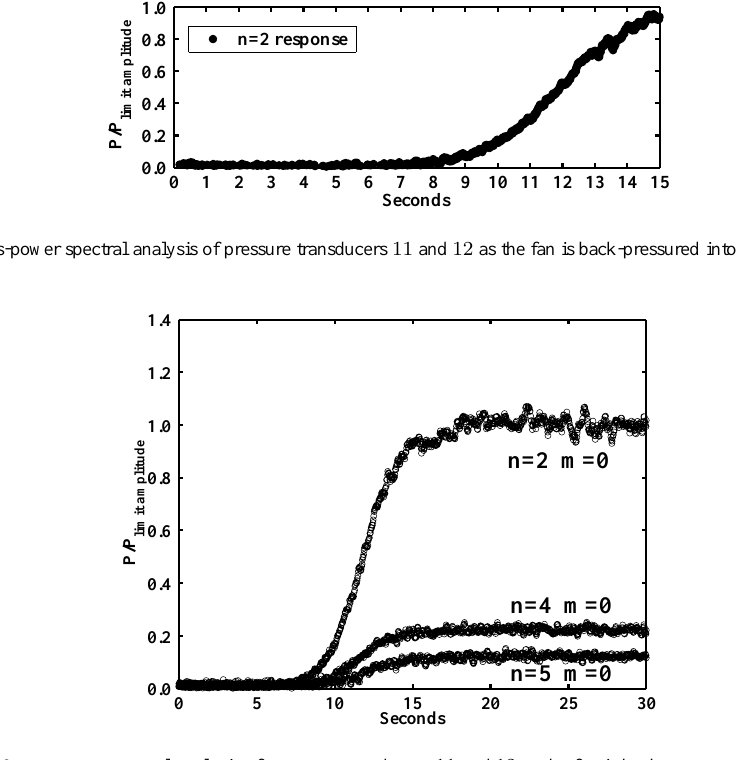
Fig. 8. Cross-power spectral analysis of pressure transducers 11 and 12 as the fan is back-pressured into